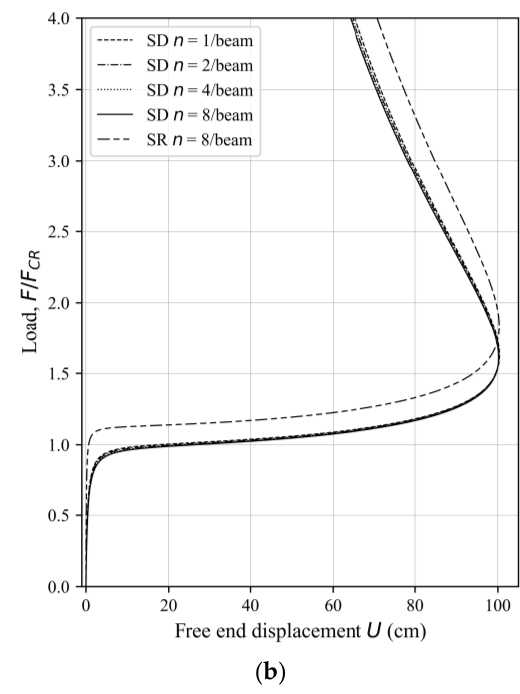
Figure 10. Buckling load convergence vs. free end displacement in the X -direction: ( a ) pre-buckling response and ( b ) post-buckling response.